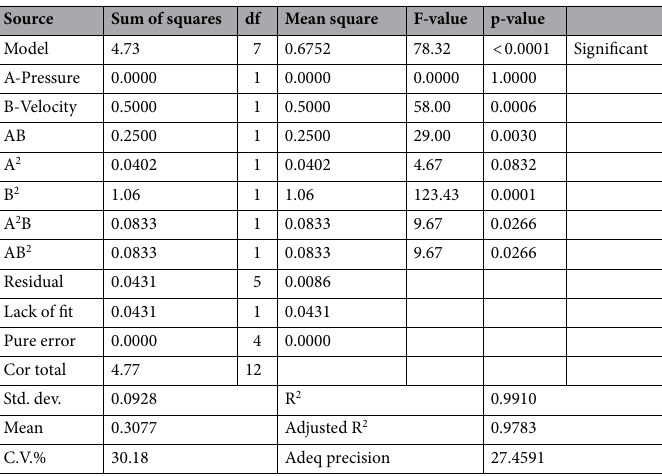
Table 21. ANOVA results for quadratic model (voids zone is response) of QAM f .